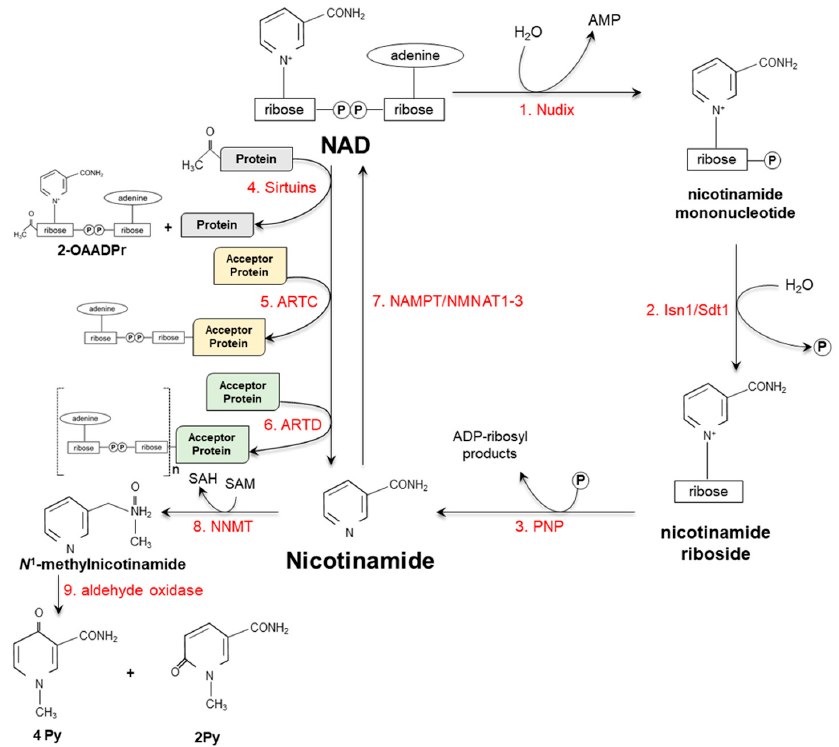
Figure 3. Schematic representation of distinct catabolic pathways. ( 1 ) NAD is hydrolyzed onto nicotinamide mononucleotide via the action of specific pyrophosphatases belonging to Nudix (nucleoside diphosphate linked to moiety X) family. ( 2 ) Nicotinamide mononucleotide is then dephosphorylated by Isn1 and Sdt1 cytosolic nucleotidases, which release the corresponding riboside cleaved to nicotinamide by a purine nucleoside phosphorylase (PNP) ( 3 ). Alternatively, NAD becomes a substrate of sirtuins ( 4 ), ADP-ribosyltransferases (ARTC) ( 5 ) and diphtheria toxin-like ADP-ribosyltransferases (ARTD) ( 6 ). Nicotinamide can be either re-converted to NAD by specific enzymes ( 7 ) (see also Figure 2) or methylated by nicotinamide- N -methyl transferase (NNMT) to N 1 -methylnicotinamide ( 8 ) that, in turn, ( 9 ) is oxidized to N 1 -methyl-4-pyridone-3-carboxamide (4-Py) and N 1 -methyl-2-pyridone-5-carboxamide (2-Py) by aldehyde oxidases. 2-OAADPr: O-acetyl-ADP ribose; NAMPT: nicotinamide phosphoribosyltransferase; NMNAT: nicotinamide/nicotinic acid-mononucleotide-adenylyltransferase; SAH: S -adenosylhomocysteine; SAM: S -adenosyl-methionine.